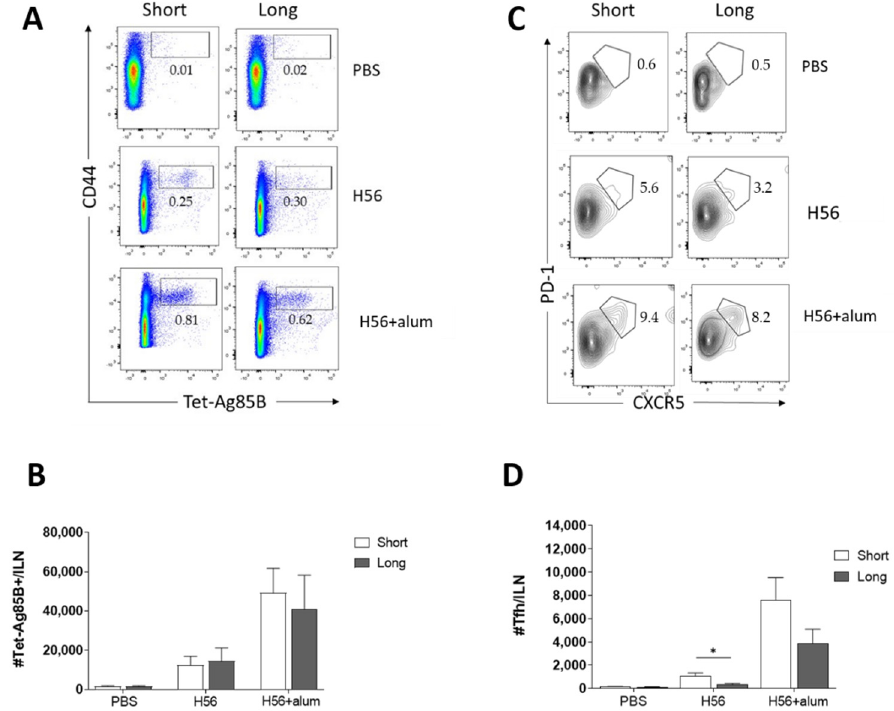
Figure 4. Induction of Ag85B-specific CD4+ T cells. C57BL/6 mice were subcutaneously immunized,